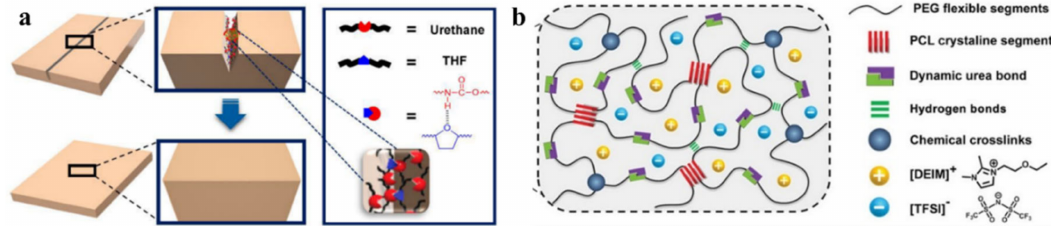
Figure 17. ( a ) Schematic representation of the PU’s self-healing mechanism. Red and blue represent a urethane group and a heterocyclic group, respectively. Reproduced from [146]. ( b ) Schematic structure of the PU-IL 2 ionogel. Reproduced from [147] with permission from John Wiley and Sons.